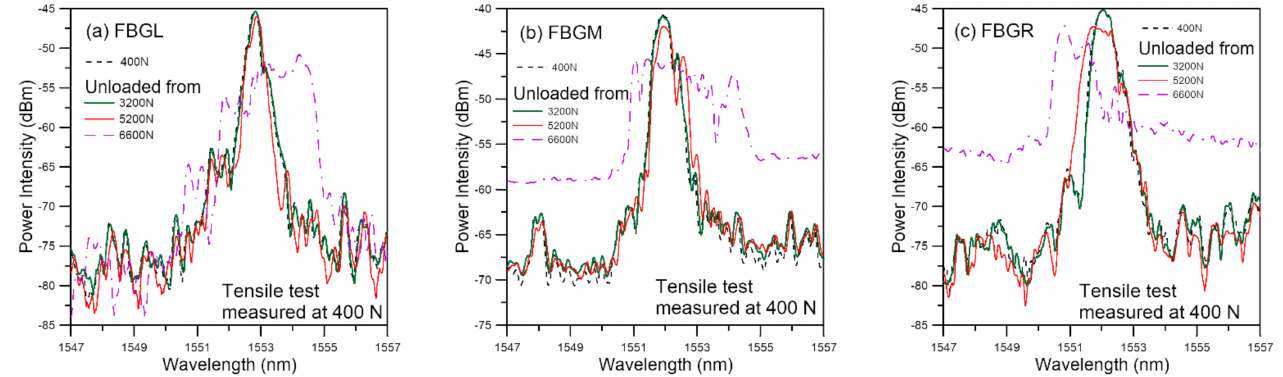
Figure 5. FBG spectra measured at 400 N after unloading from various tensile